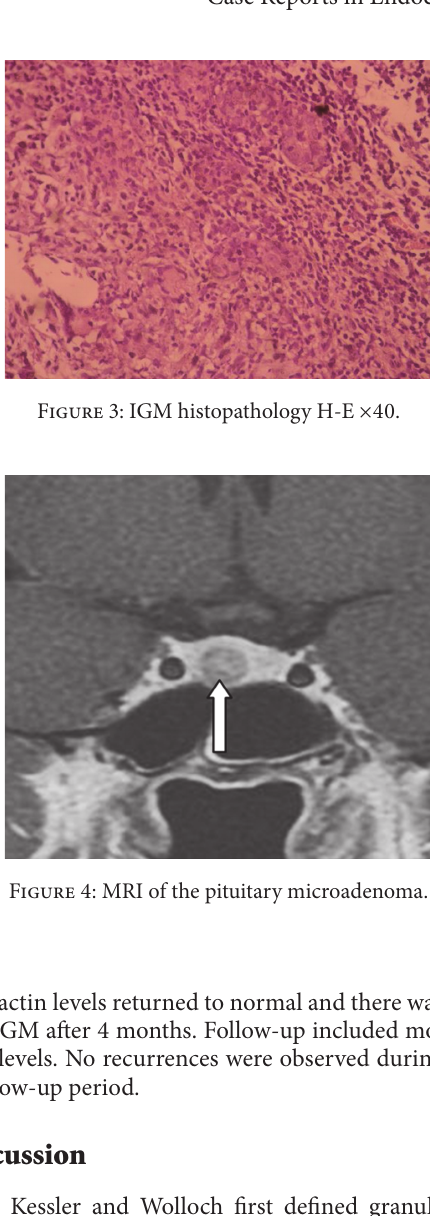
Figure 2: IGM breast USG and MRI.